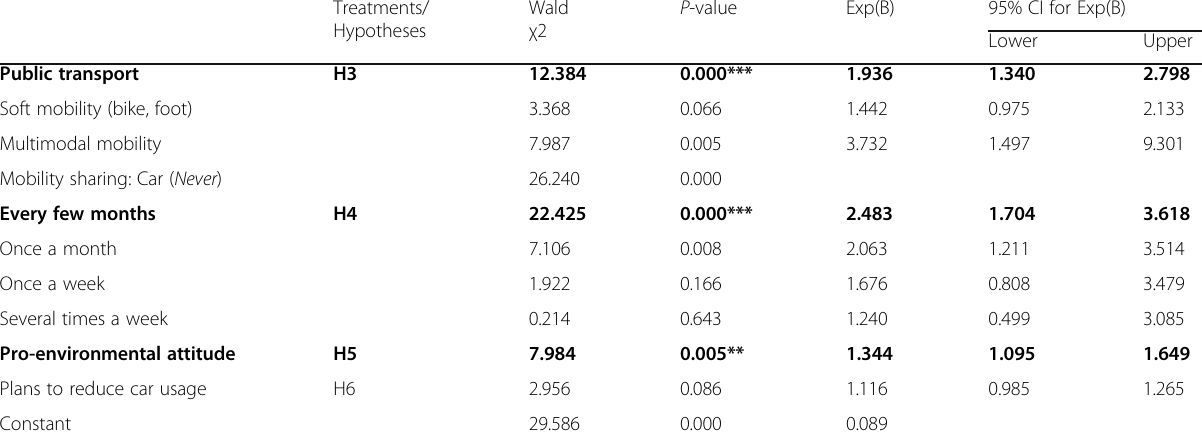
Table 4 Results of the binary logistic regression (Continued)